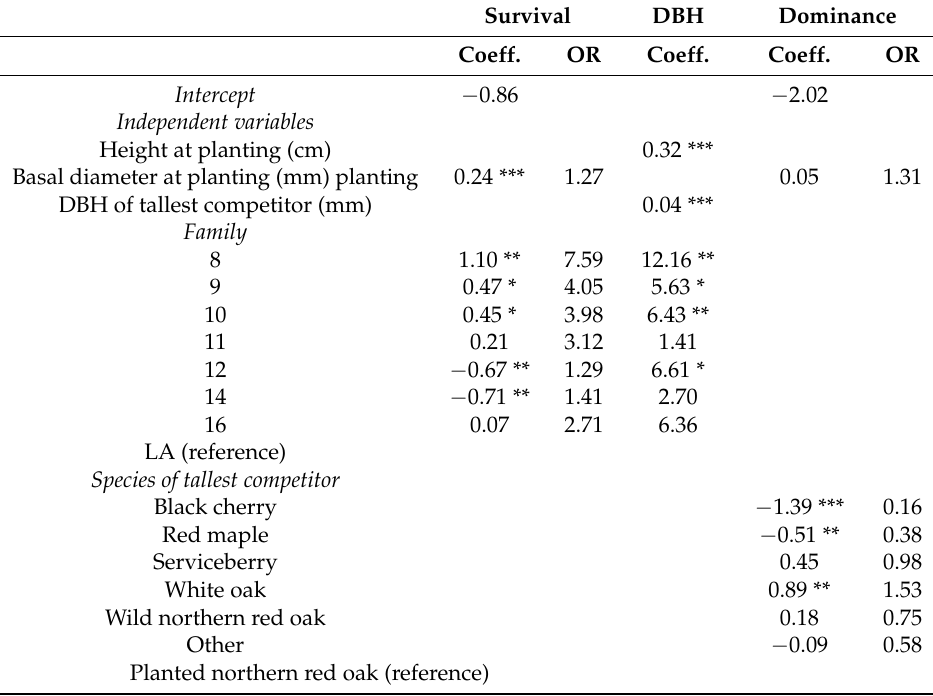
Table 3. Coefficients and odds ratio values for regression models to predict survival (logistic regression), diameter at breast height (DBH, mm, multiple linear regression), and dominance (logistic regression) of the northern red oak trees eleven years after planting. The locally available seedling treatment (LA) is the reference for the family treatment and planted northern red oak is the reference for species of tallest competitor. Survival DBH Dominance Coeff. OR Coeff. Coeff. OR Intercept − 0.86 − 2.02 Independent variables Height at planting (cm) 0.32 *** Basal diameter at planting (mm) planting 0.24 ***